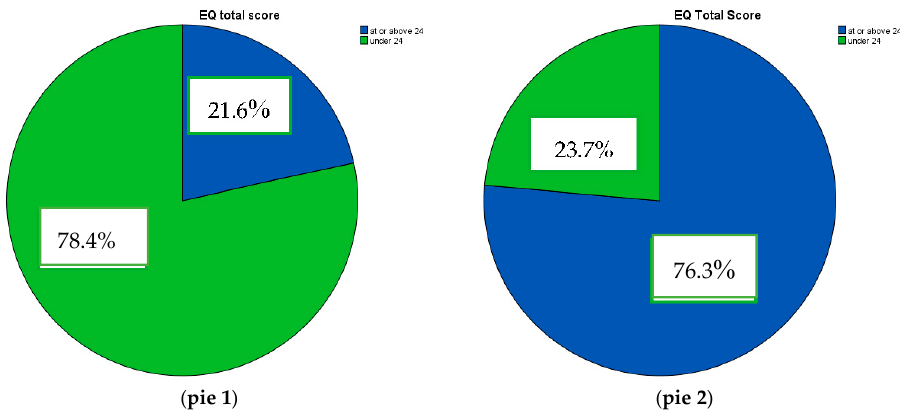
Figure 1. Percentages EQ total score in the autism group ( pie 1 ) and in the typical group ( pie 2 ), divided into scores under 24 and scores above 24.